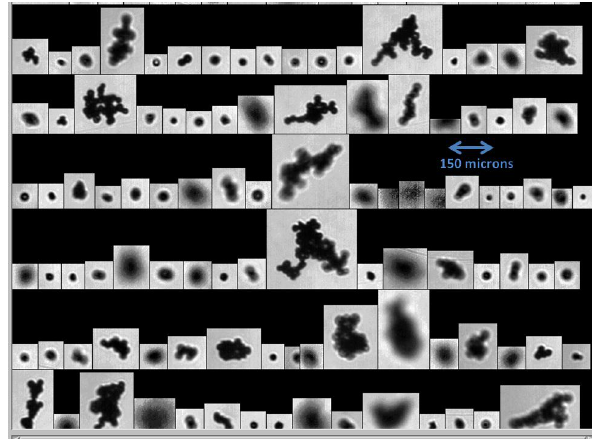
Fig. 7. CPI images of particles sampled between 22:25:51 and